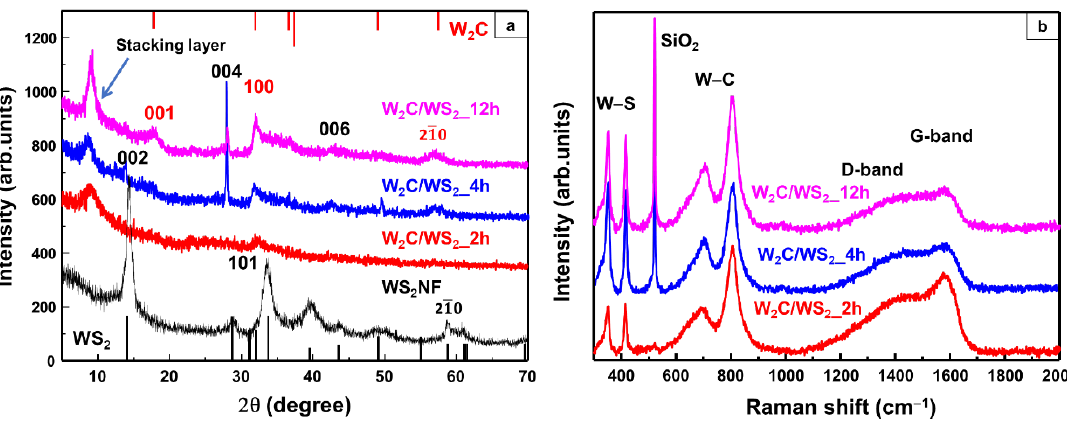
Figure 2. ( a ) X-ray di ff raction (XRD) patterns and ( b ) Raman spectra of the W 2 C / WS 2 alloy nanoflowers (NFs) synthesized by heating at 250 ◦ C for 2, 4, and 12 h.